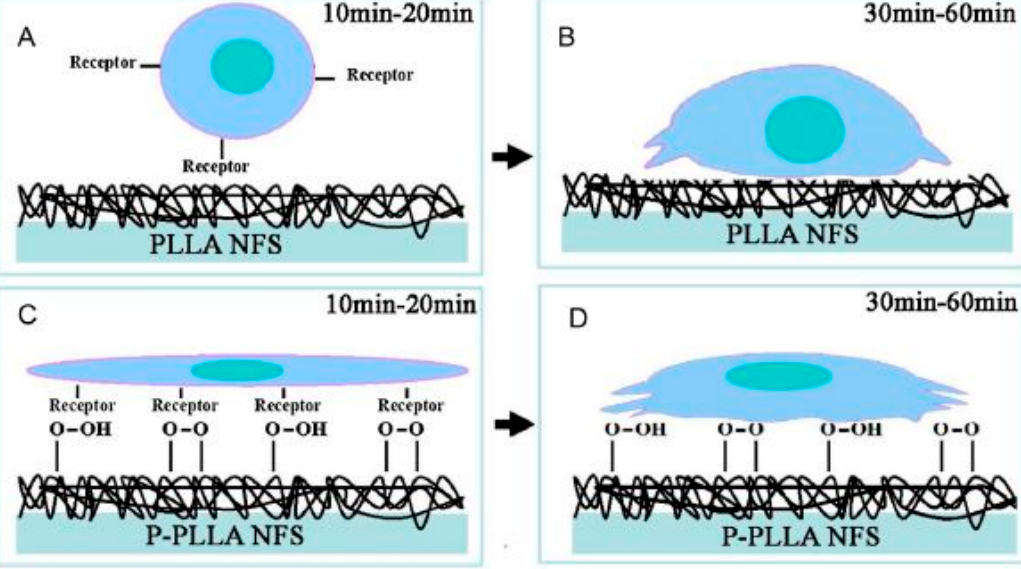
Figure 15. Schematic diagram of porcine mesenchymal stem cells (pMSCs) adhesion on pristine PLLA nanofibrous scaffolds (PLLA NFS) and O 2 plasma-treated PLLA nanofibrous scaffolds (P-PLLA NFS)—reproduced with permission from [246]. Copyright Elsevier,